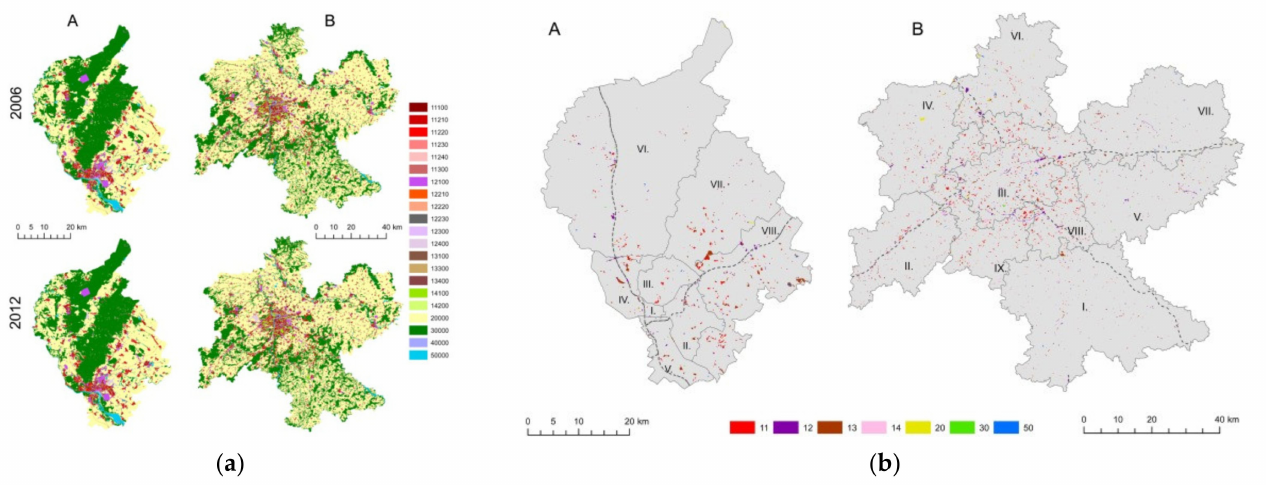
Figure 12. ( a ) LUC in (A) FUA Bratislava and B) FUA Prague in the years 2006 and 2012 according to the UA data; ( b ) LUC gains in (A) FUA Bratislava and (B) FUA Prague in the period 2006–2012 according to the UA data. Source: